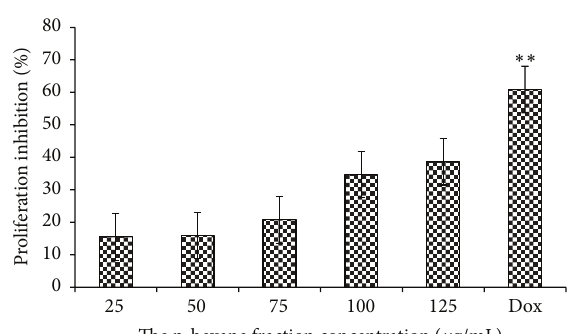
Figure 1: Percentage of proliferation inhibition K562 cells after treatment with n-hexane fraction of clove mistletoe. The data is expressed as percentage of proliferation inhibition ± SEM, as compared to the negative control (100%). Level of significance is denoted as follows: ∗∗ 𝑃 < 0.01